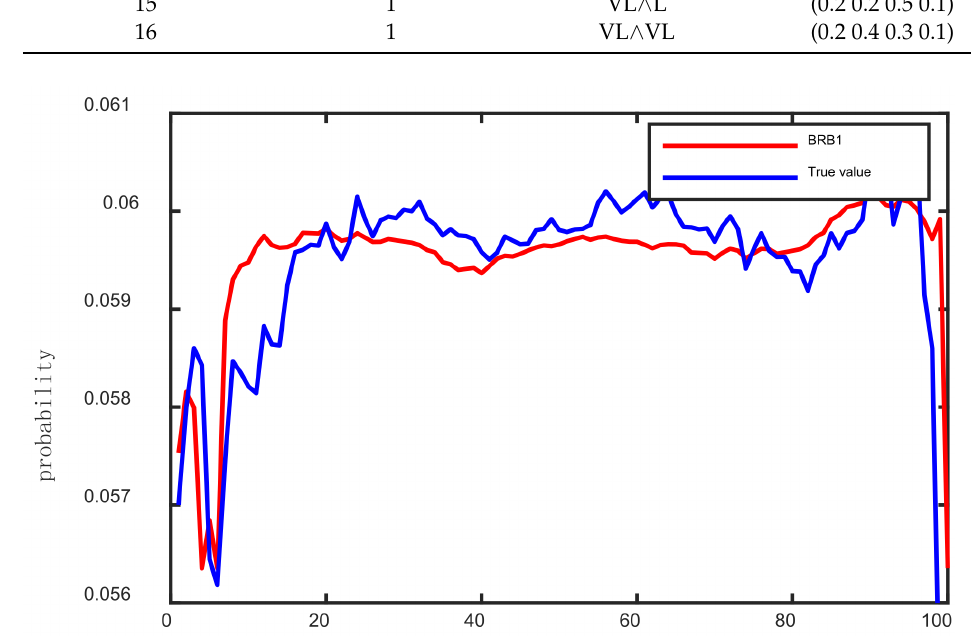
Figure 8. BRB1 output results.